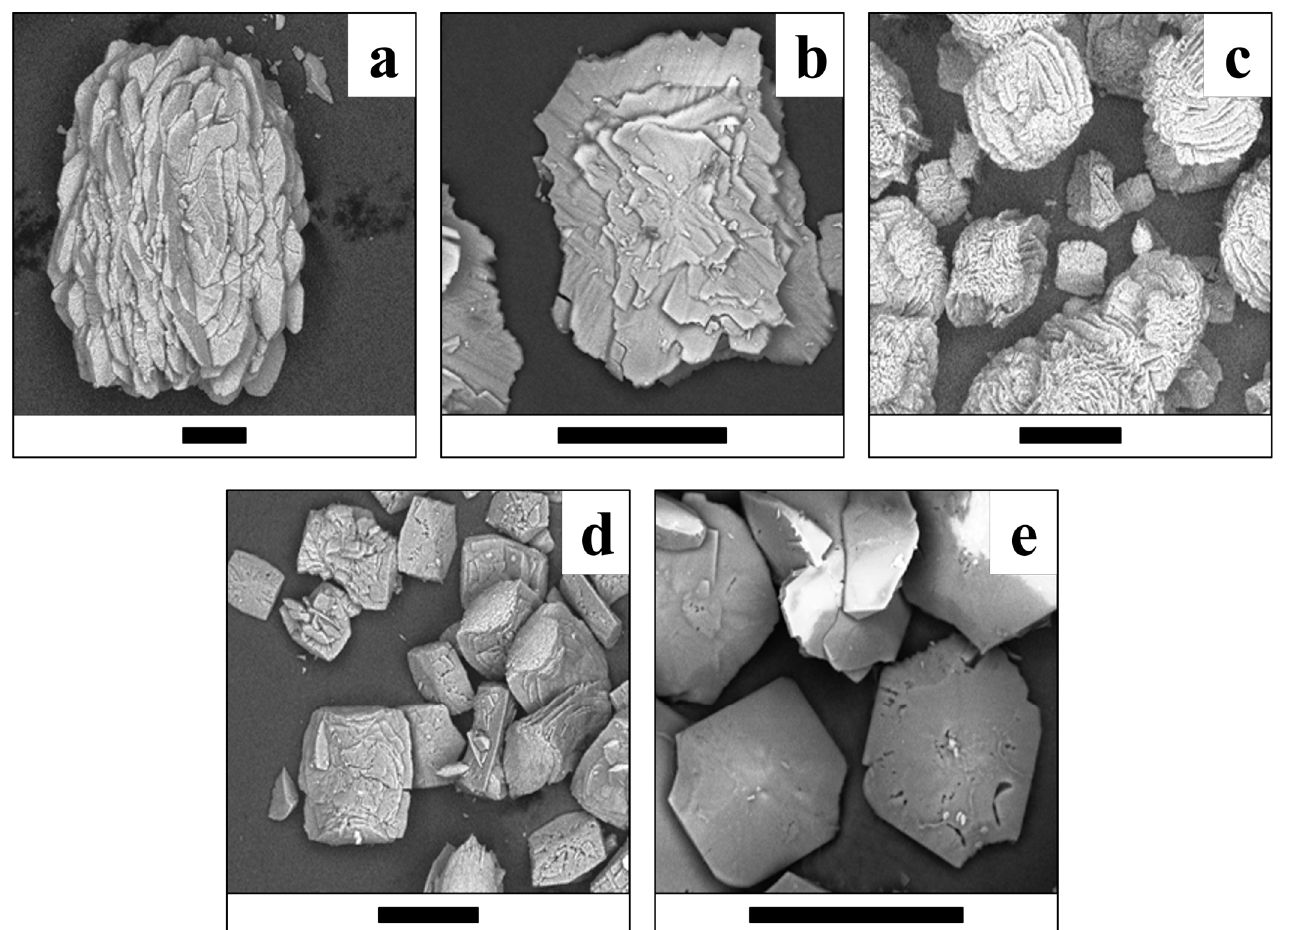
Figure 11. Crystals of (Mg,Mn) C2O4 ∙ 2H2O solid solutions (SC series) obtained at various Mg/(Mg + Mn) ratios in solution. ( a )—0%; ( b )—30%; ( c )—75%; ( d )—80%; ( e )—100%. Black bar is 100 μ m.